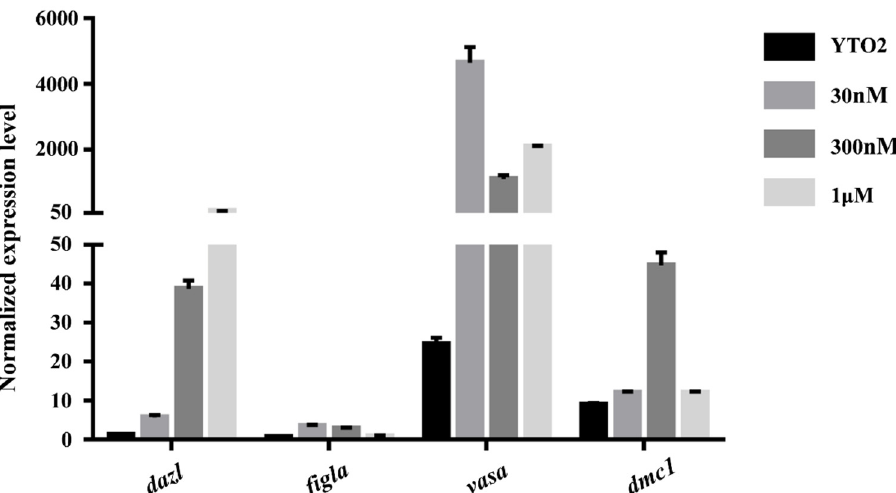
Figure 7. The alteration of marker genes expression in the YTO2 cells induced by retinoic acid (RA). The cultured YTO2 cells were exposed to RA (at the concentration of 30 nM, 300 nM and 1 µ M) for 24 h, and the total RNA of treated and control YTO2 cells were extracted for qRT-PCR analysis. The result showed that the dazl and vasa mRNA expression were increased after RA treatment at all three dosage, figla was weakly expressed in control and 1 µ M RA treated cells, but strongly in 30 nM and 300 nM RA treated cells. Dmc1 was weakly expressed in control, 30 nM, 1 µ M and strong in RA treated cells at the concentration of 300 nM.